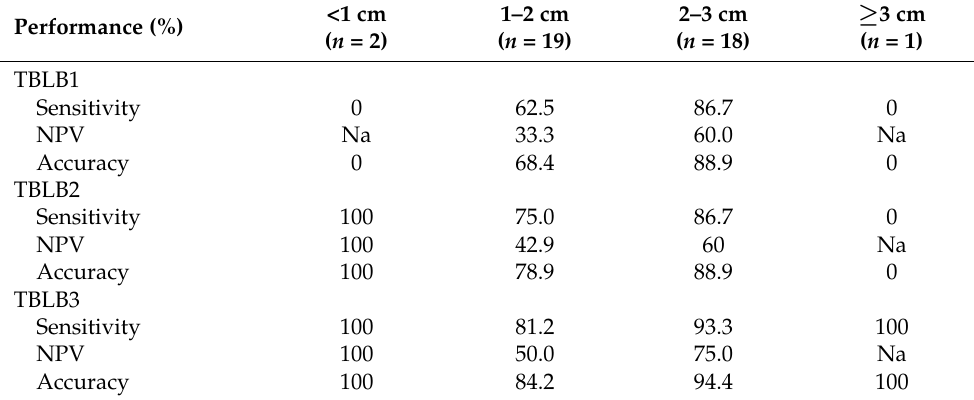
Table 3. Diagnostic performance in each modality according to the